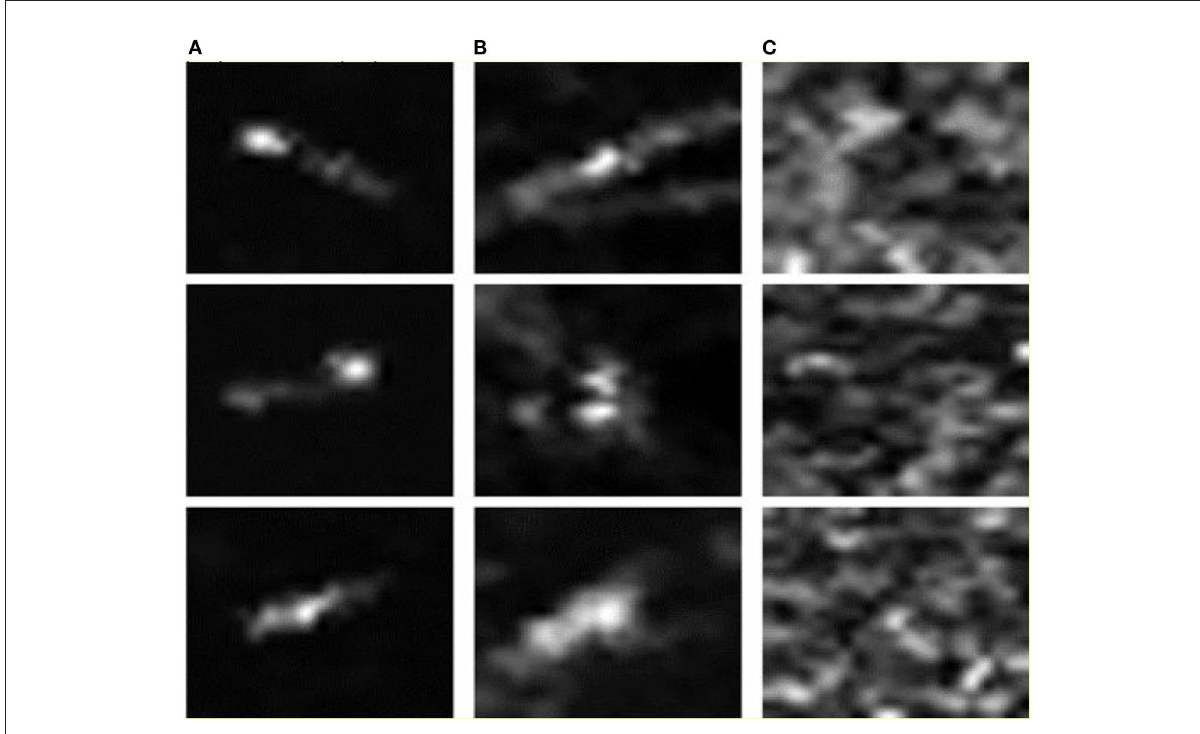
FIGURE7 Nine examples of the three types of sub-images in the SAR-Dataset. (A) Ship images; (B) Ship-like images; (C) Ocean background